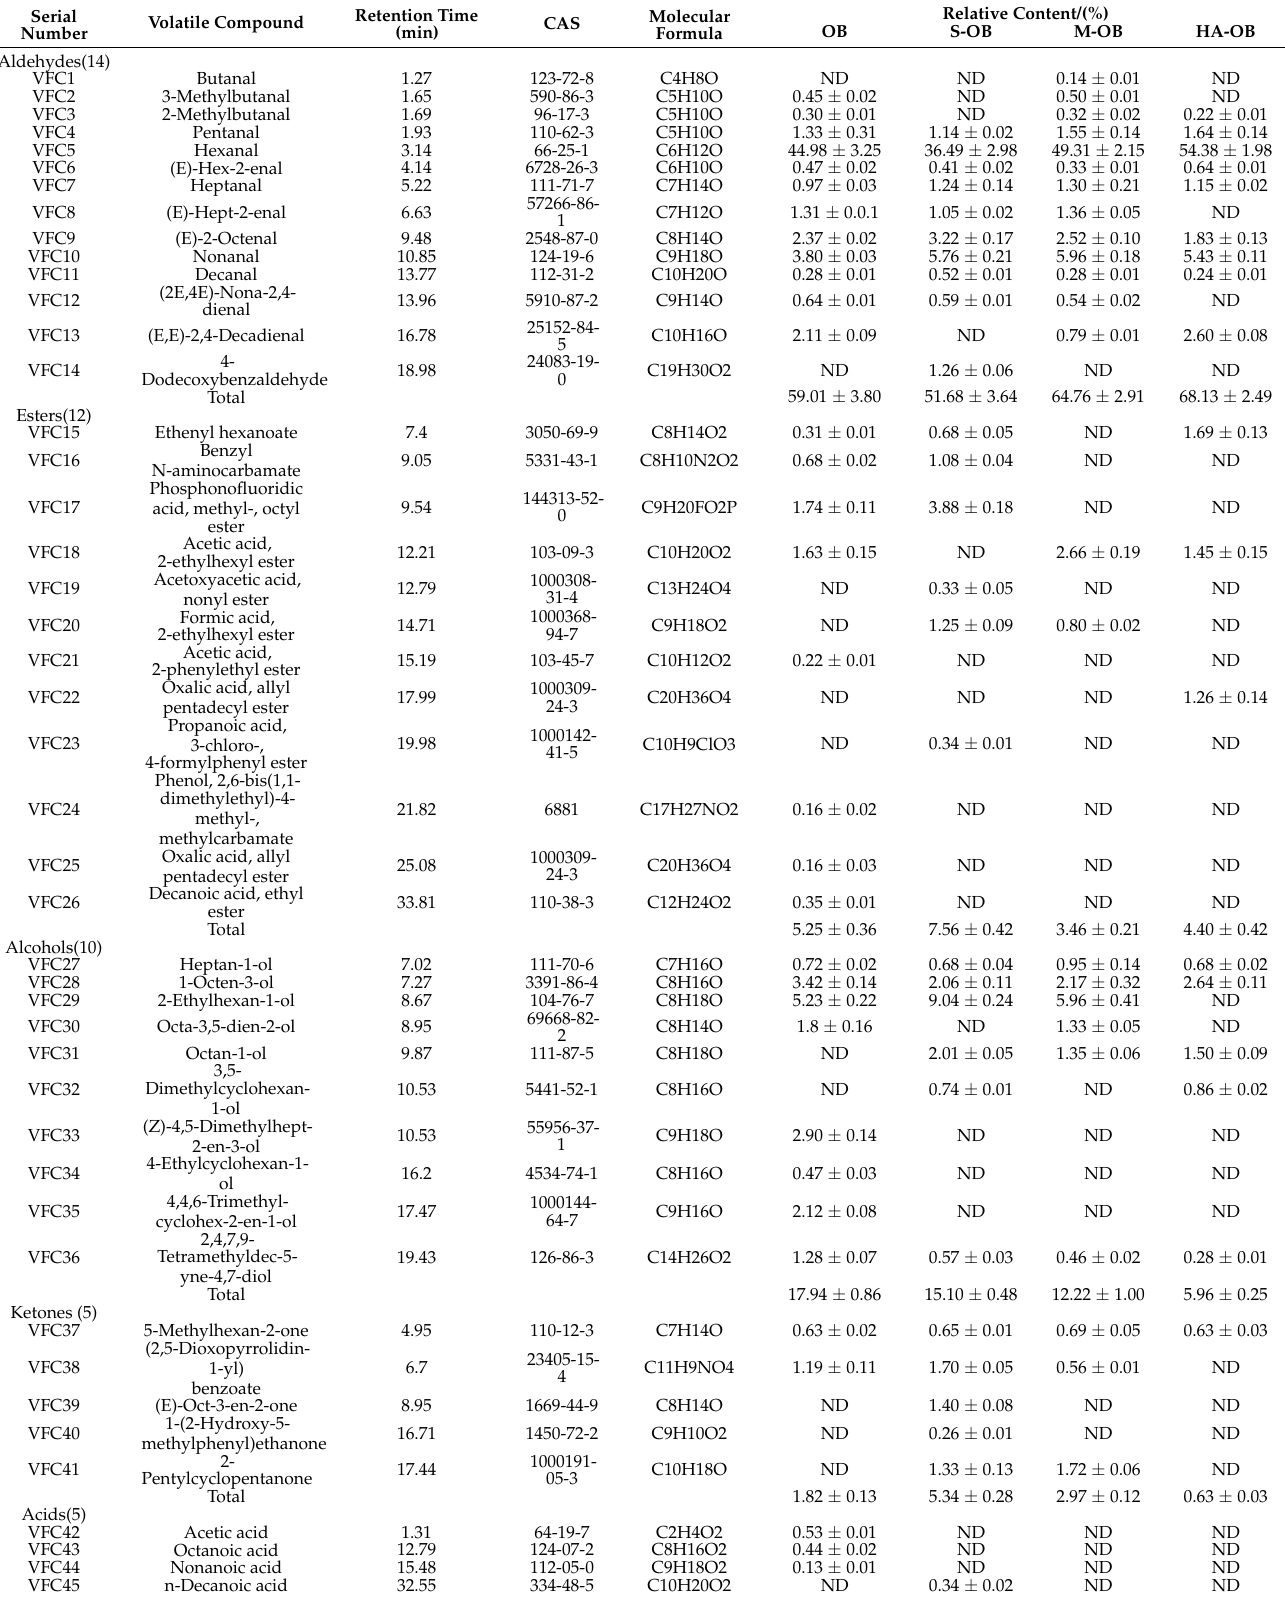
Table 2. Composition and relative content of volatile composition of oat bran under different